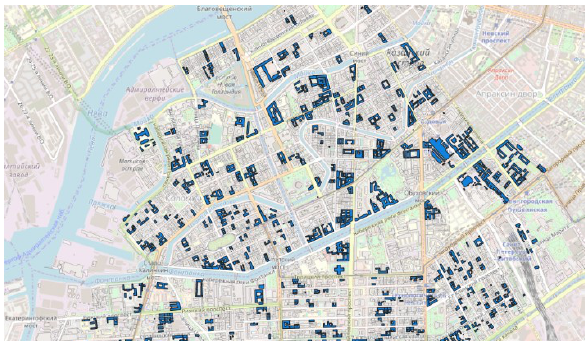
Figure 5. Visualization of tuberculosis cases reported in 2008 in Admiralteysky district of St. Petersburg (base map © OpenStreetMap contributors)